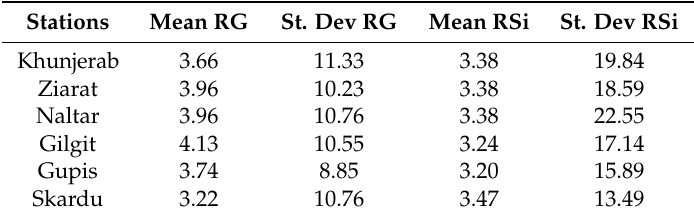
Table 7. Back-casting station wise comparison of second-order moments of daily precipitation (Mean and Standard Deviation) of all stations for 30 years of